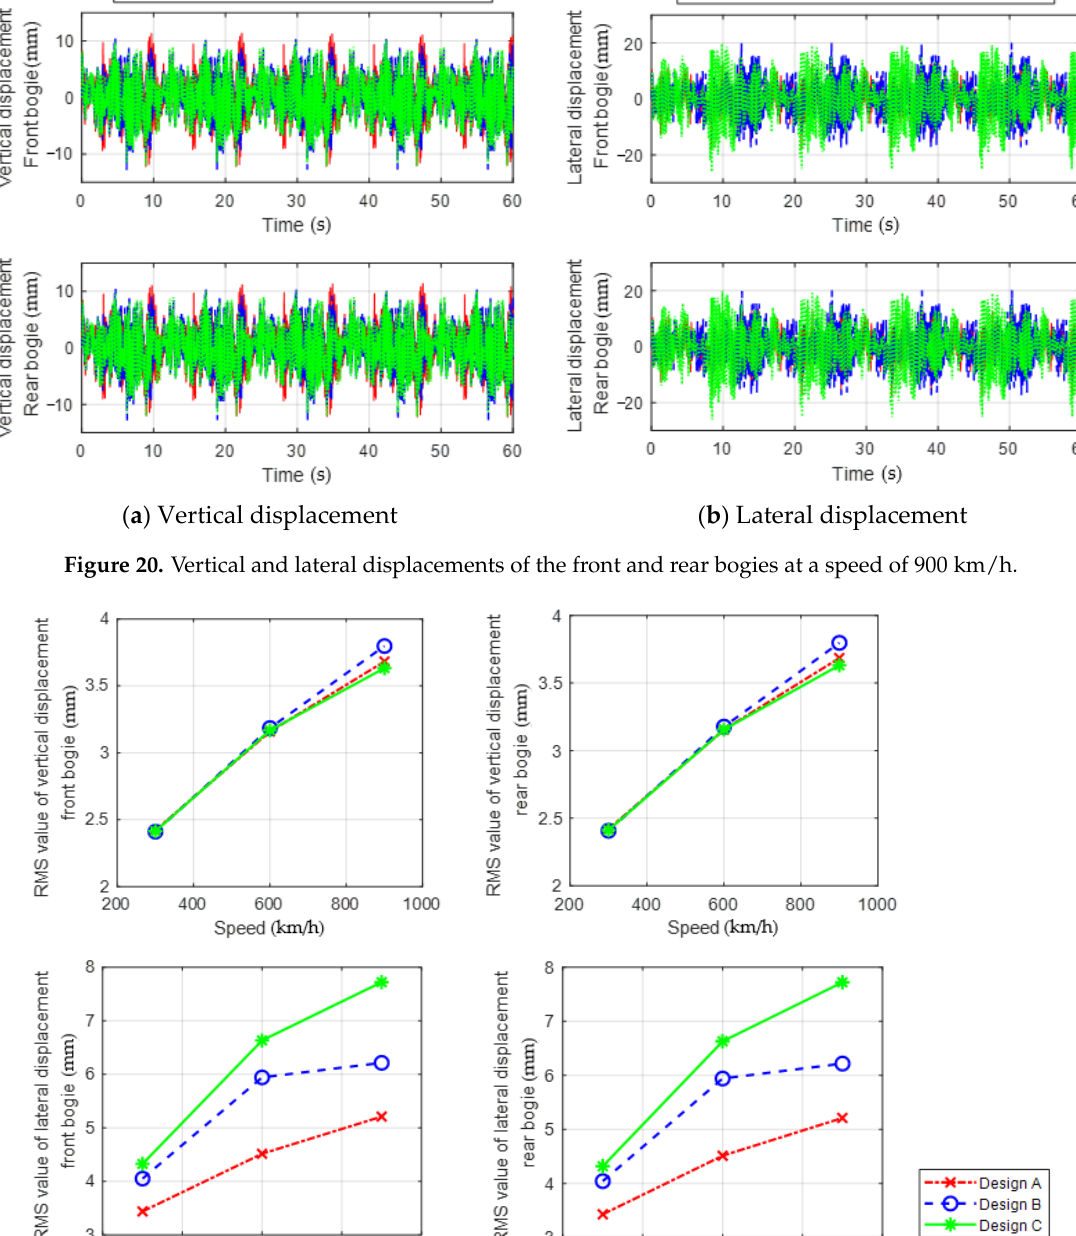
Figure 19. Vertical and lateral displacements of the front and rear bogies at a speed of 600 km/h.